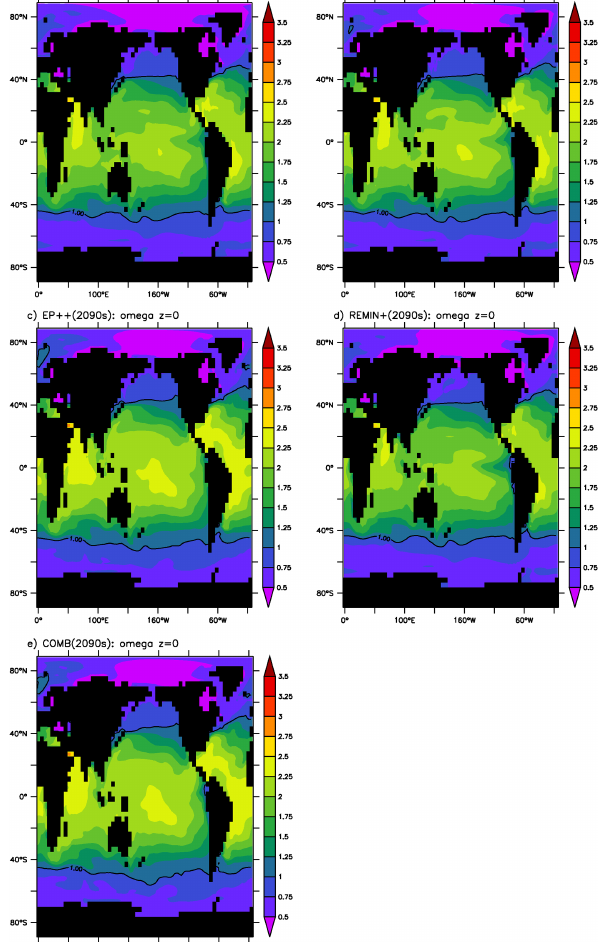
Figure 5. Annual mean surface aragonite saturation state during the 2090–2100 period for (a) REF; (b) EP+; (c) EP++; (d) REMIN+; and (e) COMB